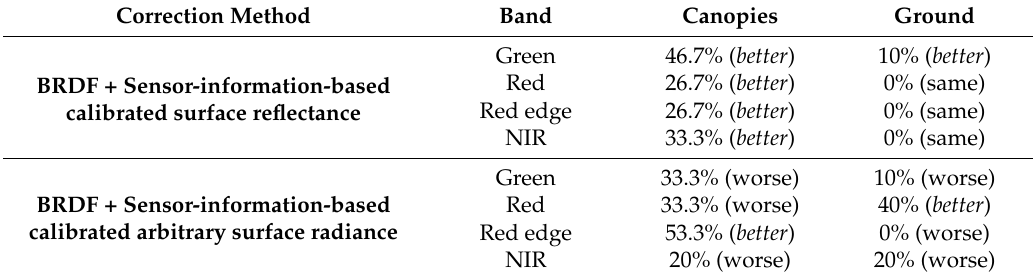
Table 2. Consistency assessment results for banana from box-and-whisker comparison between two temporally close